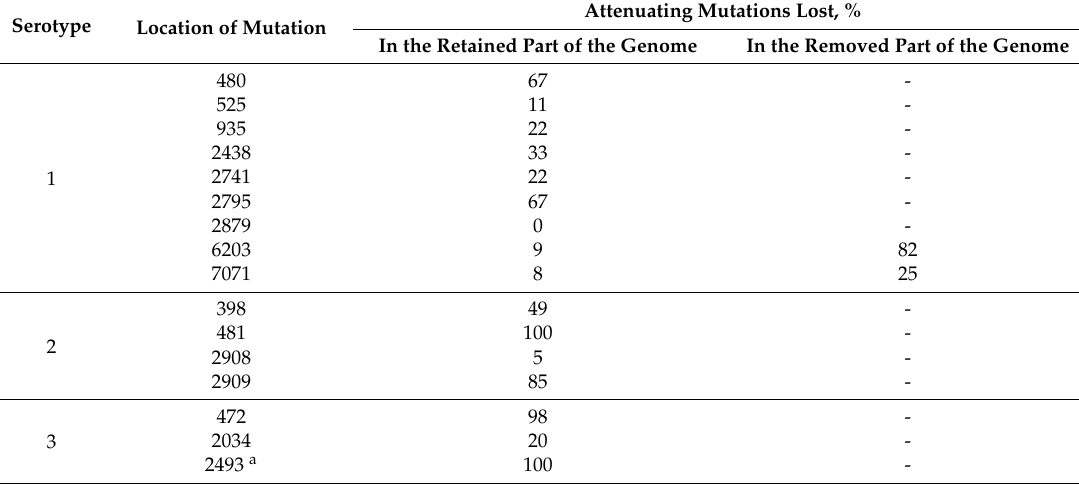
Table 2. Loss of attenuating and/or temperature-sensitive ( ts ) mutations in the set of recombinants with the fully sequenced